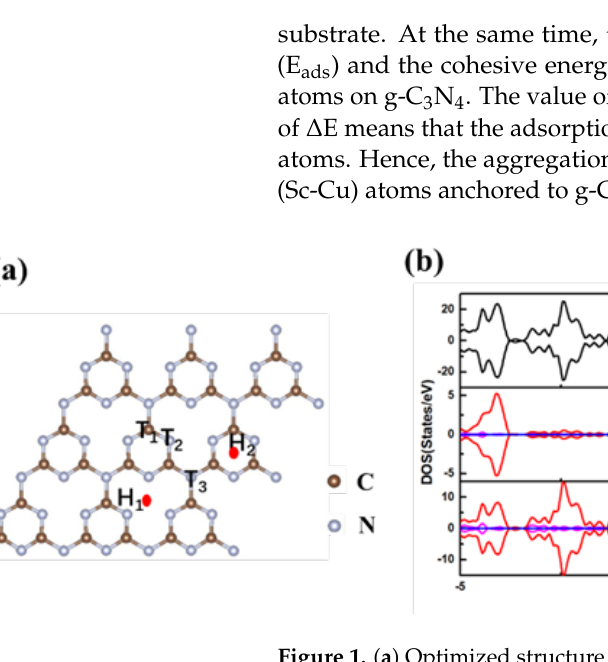
Figure 1. ( a ) Optimized structure and ( b ) DOS of s-tri-based g-C 3 N 4 monolayer, ( c ) stable configura- tion of Mn@g-C 3 N 4 . Table 1. Adsorption energies (E ads , eV), energy difference ( ∆ E, eV) between adsorption energy and cohesive energy, total magnetic moments (M tot , µ B ), the charge ( ∆ Q, e) transferred from the TM atoms to g-C 3 N 4 monolayer, and the electronic structures (ES) (SM: semi-metallic, M: metallic and SC: